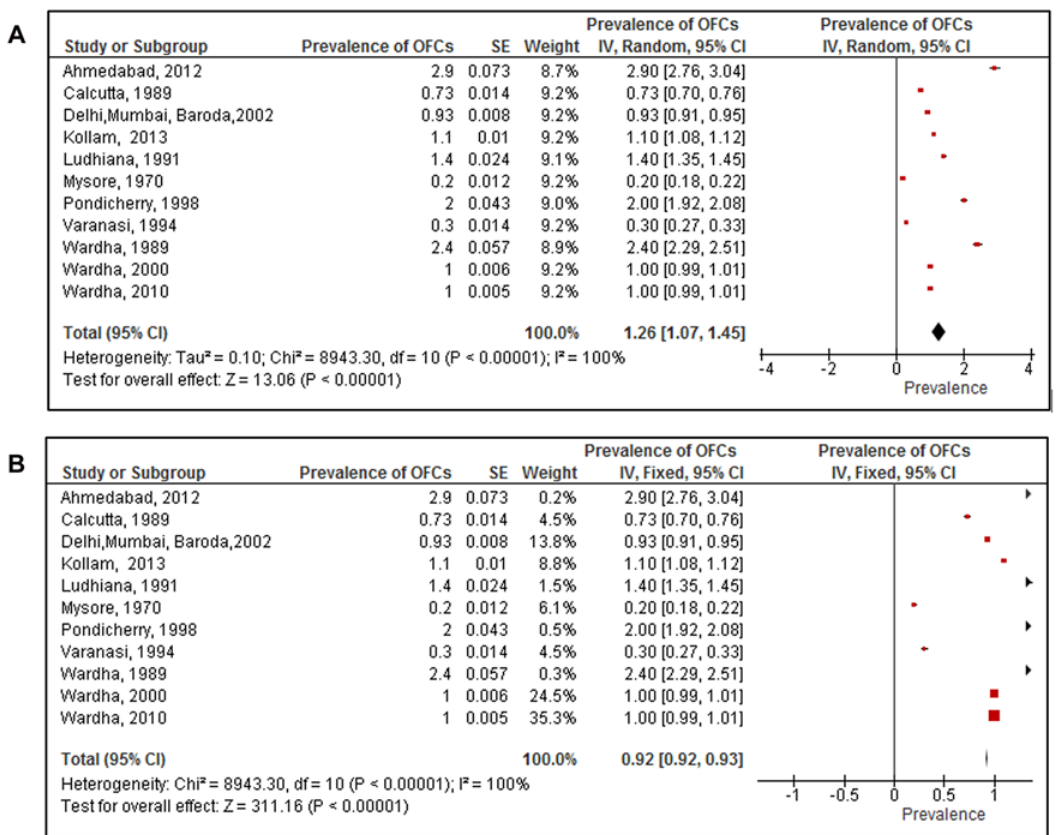
Fig 3. Prevalence of orofacial clefts among studies included in the systematic review and meta-analysis. (A) Pooled prevalence of orofacial clefts using the random effects model. (B) Pooled prevalence of orofacial clefts using fixed effects